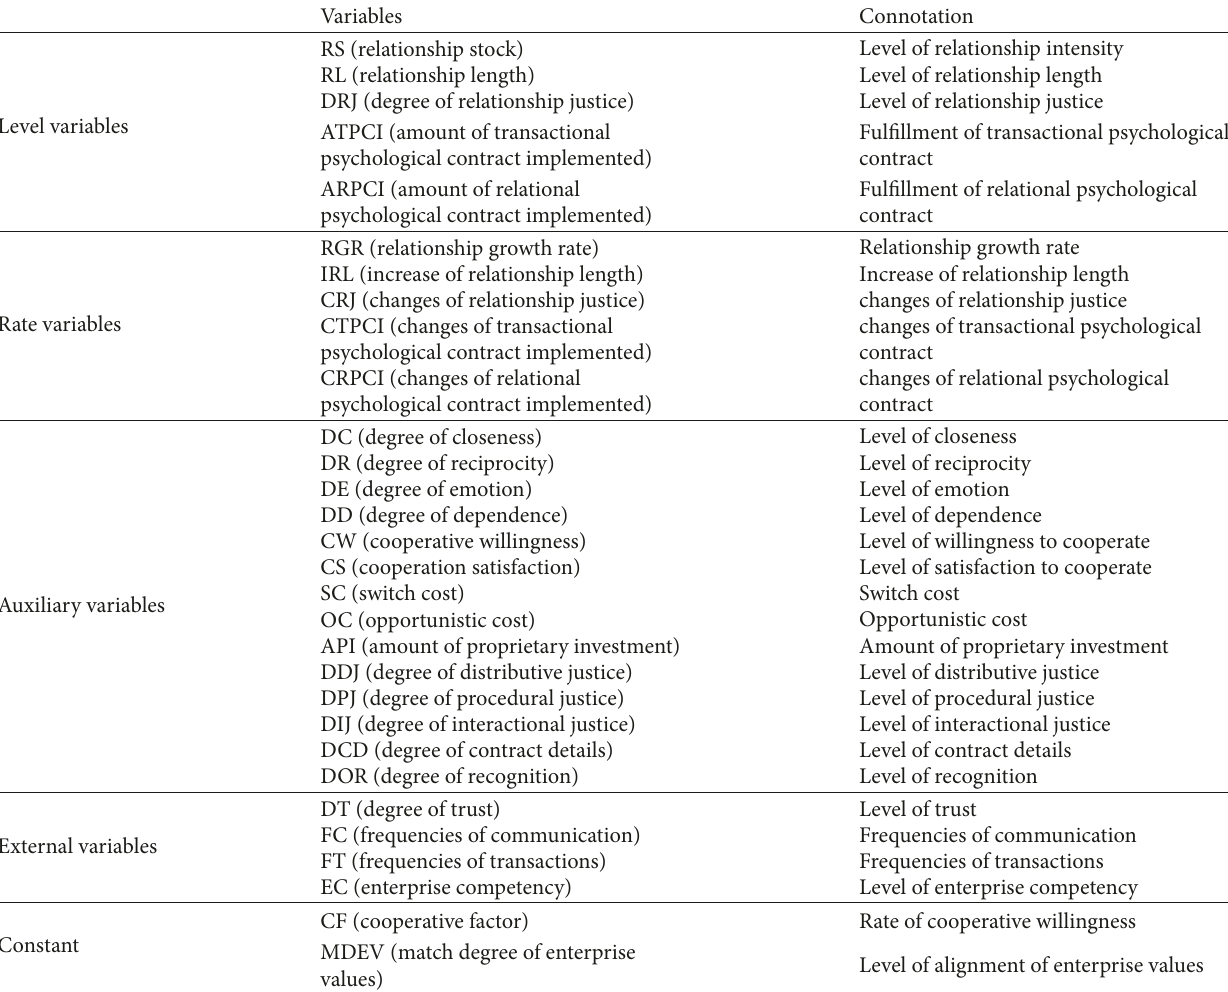
Table 1: Parameter list of SD model of coevolution of IORs and